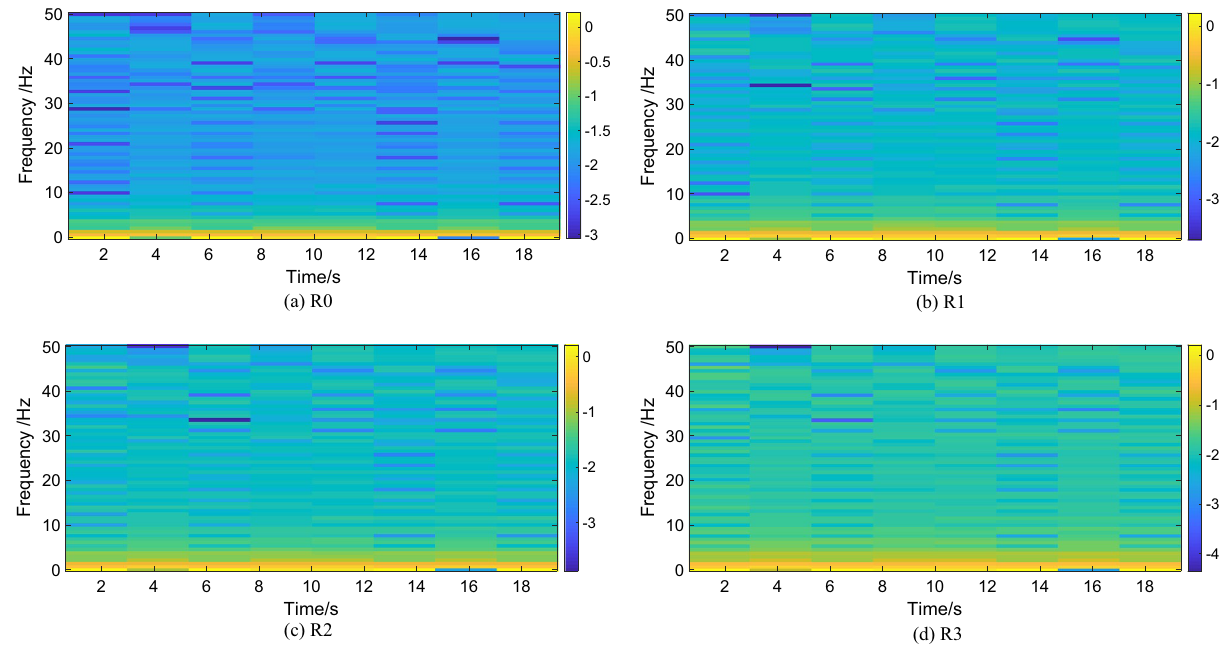
Figure 4. STFT spectrum of output signal in different states.